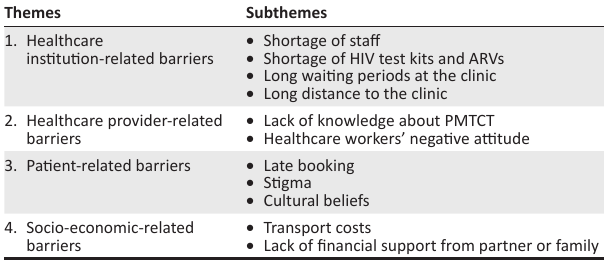
TABLE 4: Identified Themes and